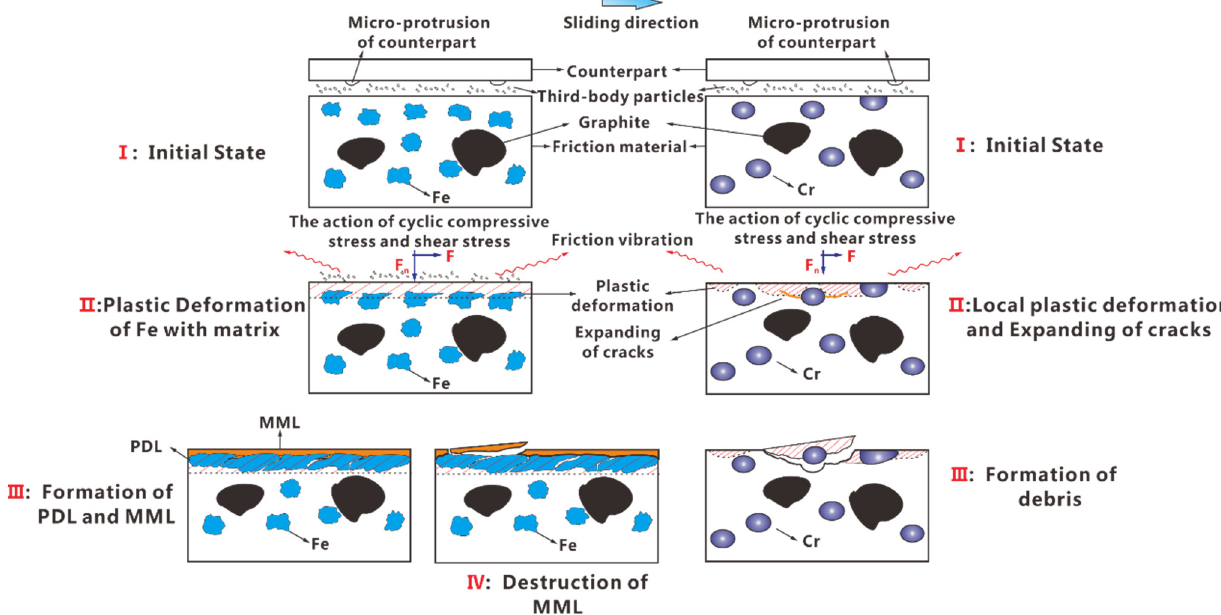
Figure 14. Evolution of the wear mechanism for Cu–BCs containing Fe and Cr under high BEPUA.